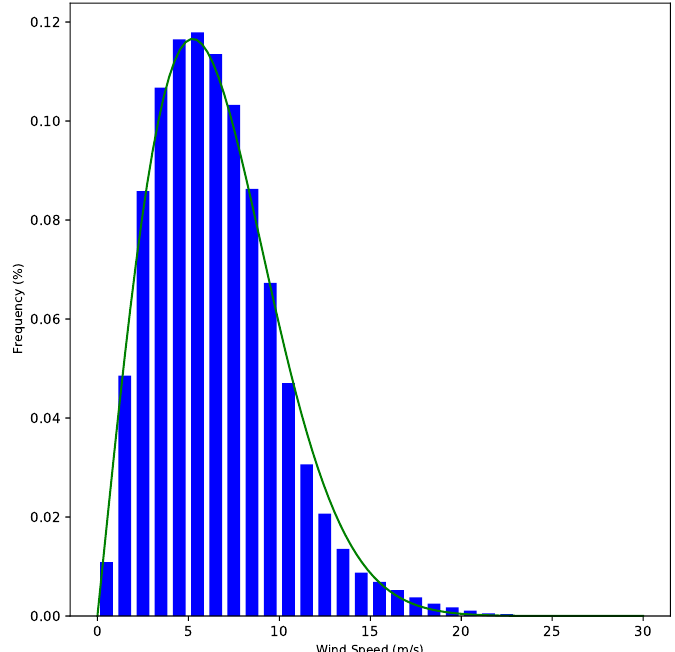
Figure A2. Wind speed distribution for WM10 Butterworth at 60 m above ground level. Butterworth is a town in the Eastern Cape province of South Africa. The wind data, as shown, represents a 2-year period from March 2011 to February 2012 and October 2012 to December